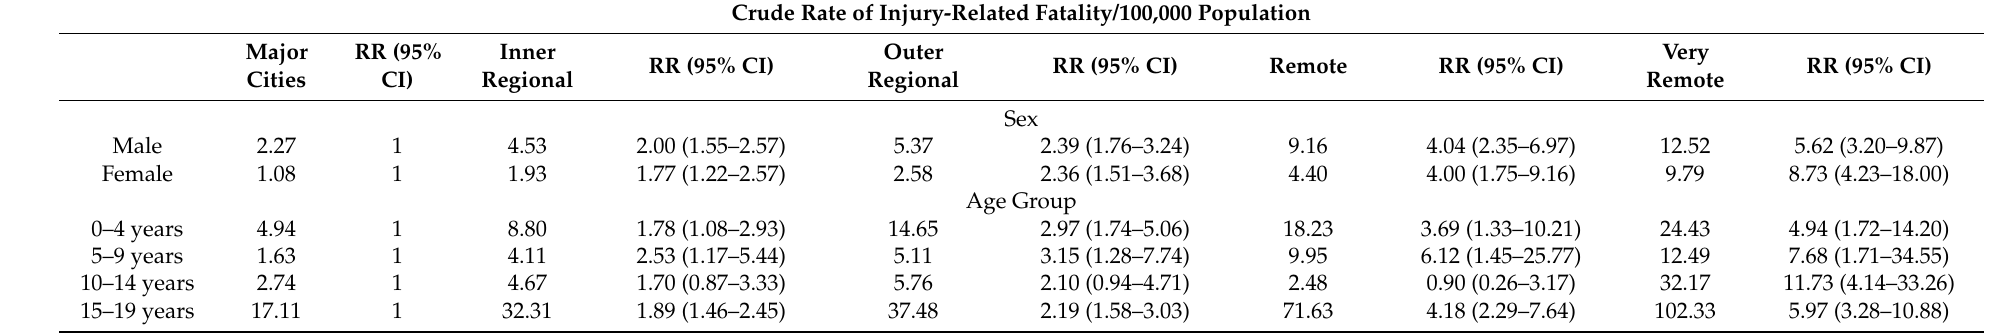
Table 4. Crude rate of injury-related fatality by remoteness classification, relative risk (RR) with 95% confidence interval (CI), children and adolescents 0–19 years of age, Australia, 2007-08–2016-17. Crude Rate of Injury-Related Fatality/100,000